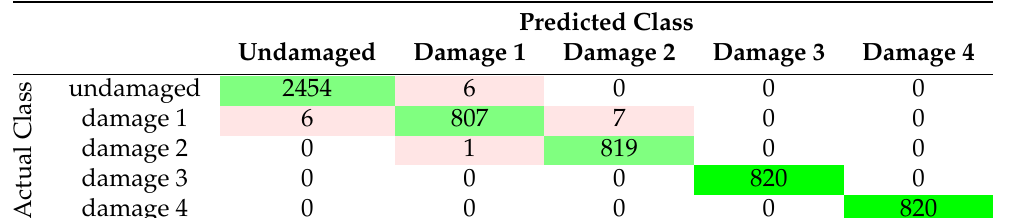
Table 8. Total added confusion matrix for d = 5. Correct decisions are placed in cells with green background while wrong decisions are placed in cells with red background.